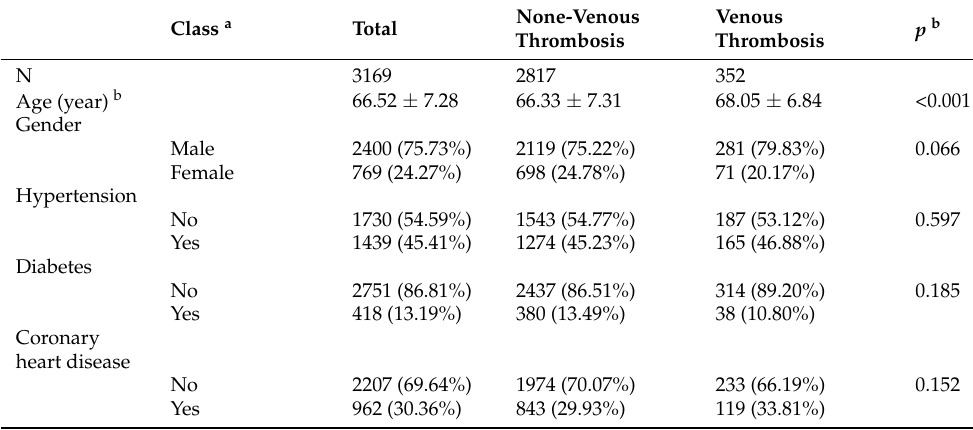
Figure 1. Flow chart of patients for enrollment. Table 1. Characteristics of the patients stratified by VTE or not.